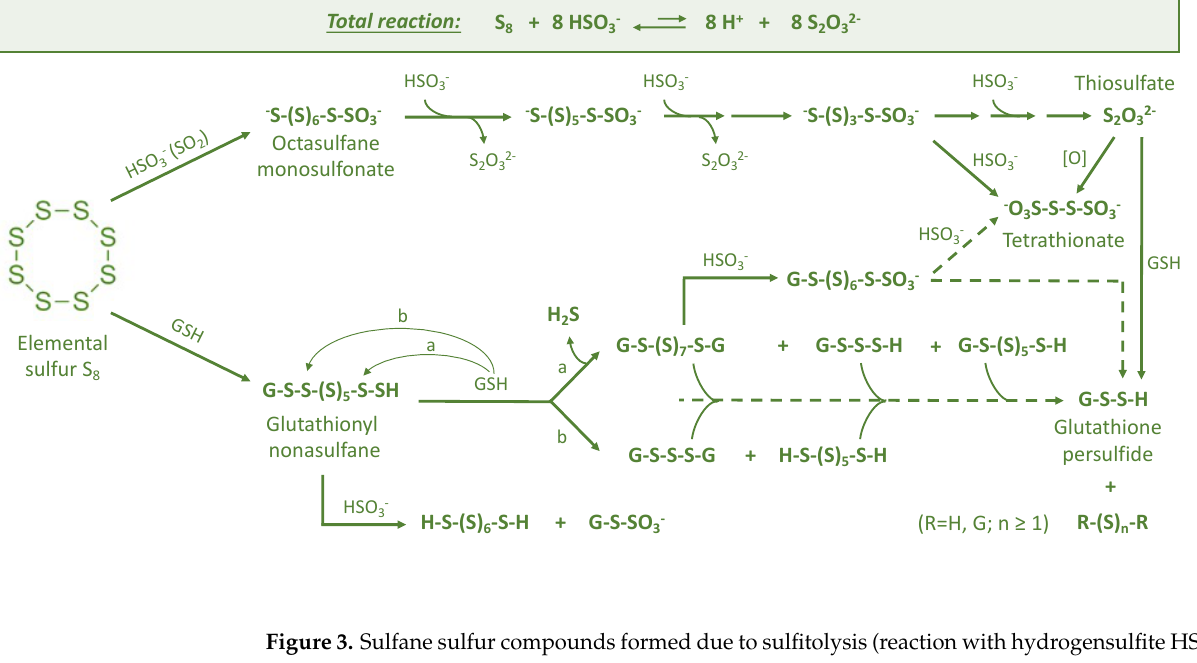
Figure 3. Sulfane sulfur compounds formed due to sulfitolysis (reaction with hydrogensulfite HSO 3 − ) and thiolysis (reaction with glutathione GSH) of elemental sulfur at wine pH: detailed chemical transformations for Figure 2, the part colored green (based on